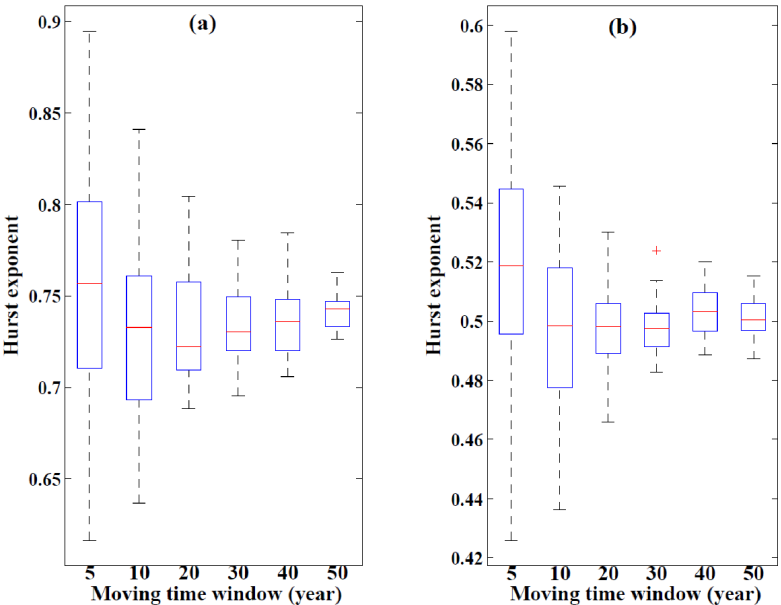
Figure 6. Box plots of the Hurst exponents under different moving time windows for (a) Well 1 groundwater levels and (b) Well 2 ground- water